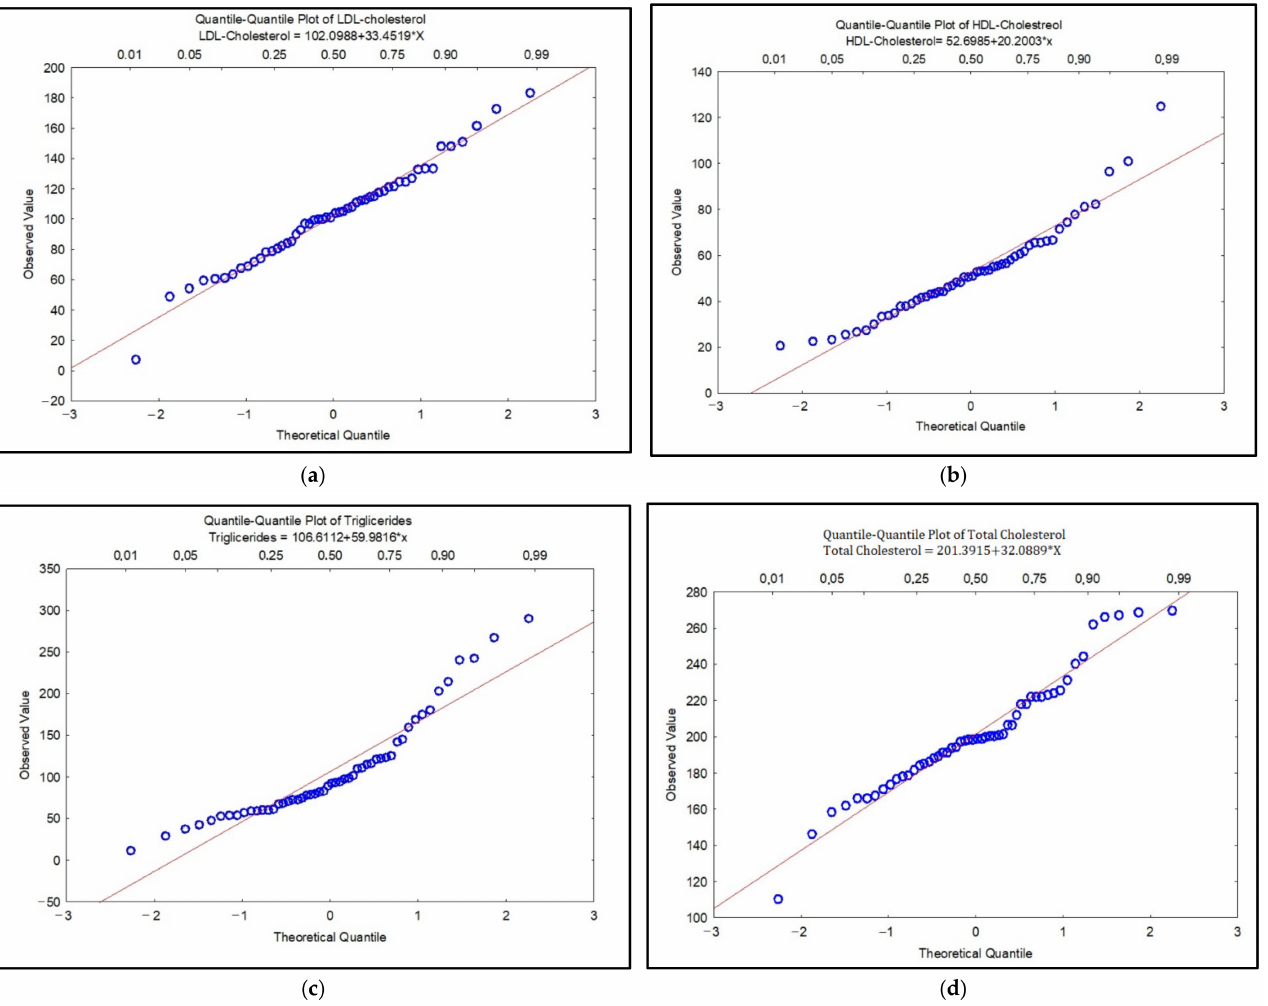
Figure 1. Q–Q plot for LDL-cholesterol (mg/dL) ( a ); HDL-cholesterol (mg/dL) ( b ); triglycerides ( c ) and total cholesterol ( d